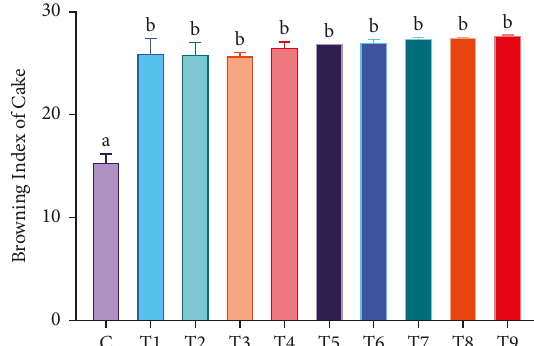
Figure 3: Comparison of Browning reaction of quinoa cake treatments and control. The crusts of cake samples were tested with the colorimeter. Increasing of quinoa flour enhances dark brown components. The data are expressed as mean experiments. Inter-group comparisons were made using one way ANOVA.Different lowercase letters represent significant differences at p 0 . 05 probability <